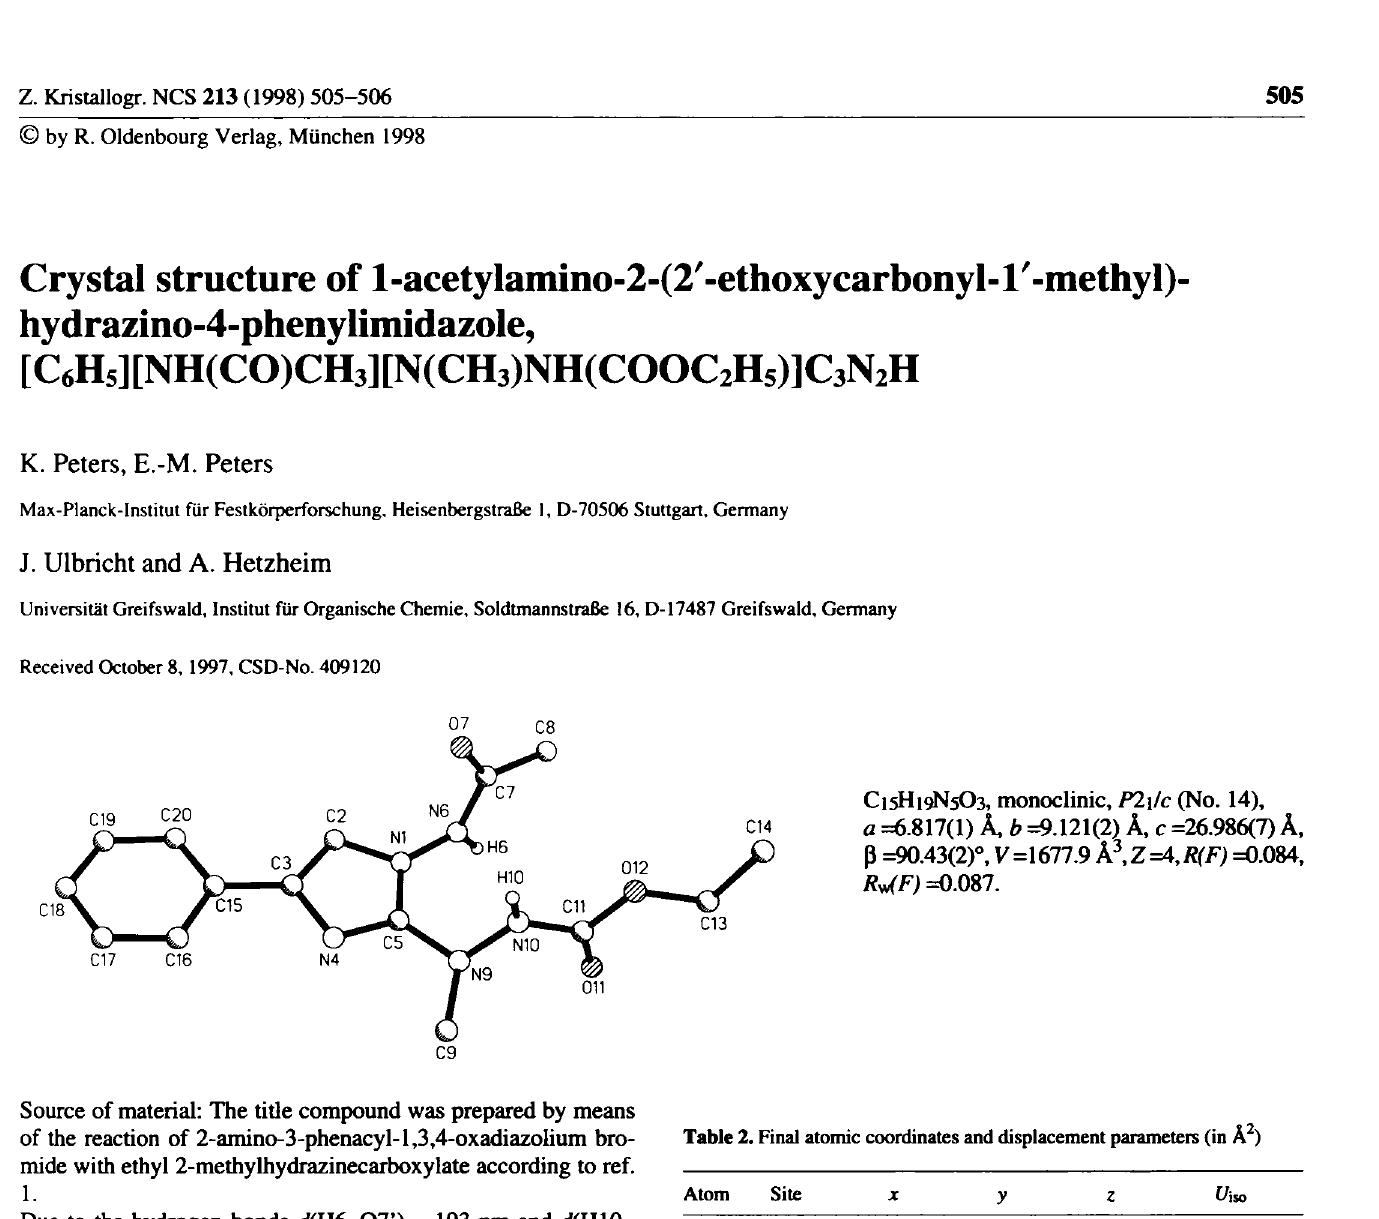
Table 1. Parameters used for the X-ray data collection